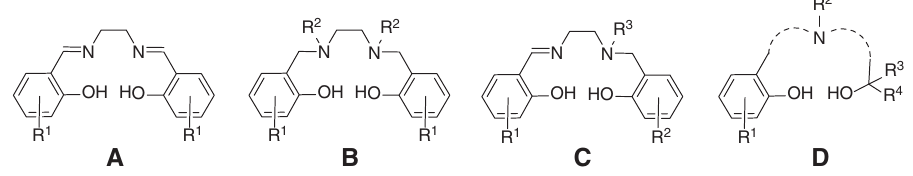
Figure 1: Examples of salen, salen, hemisalen and mixed phenol/alcohol